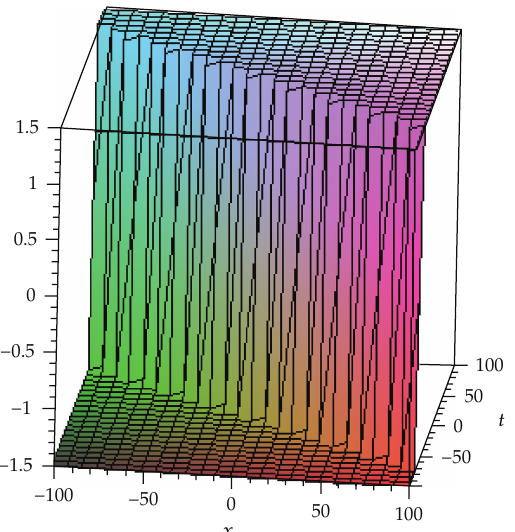
Figure 2: Periodic solution for β (cid:8) 2, y (cid:8) 0 and z (cid:8) 0.